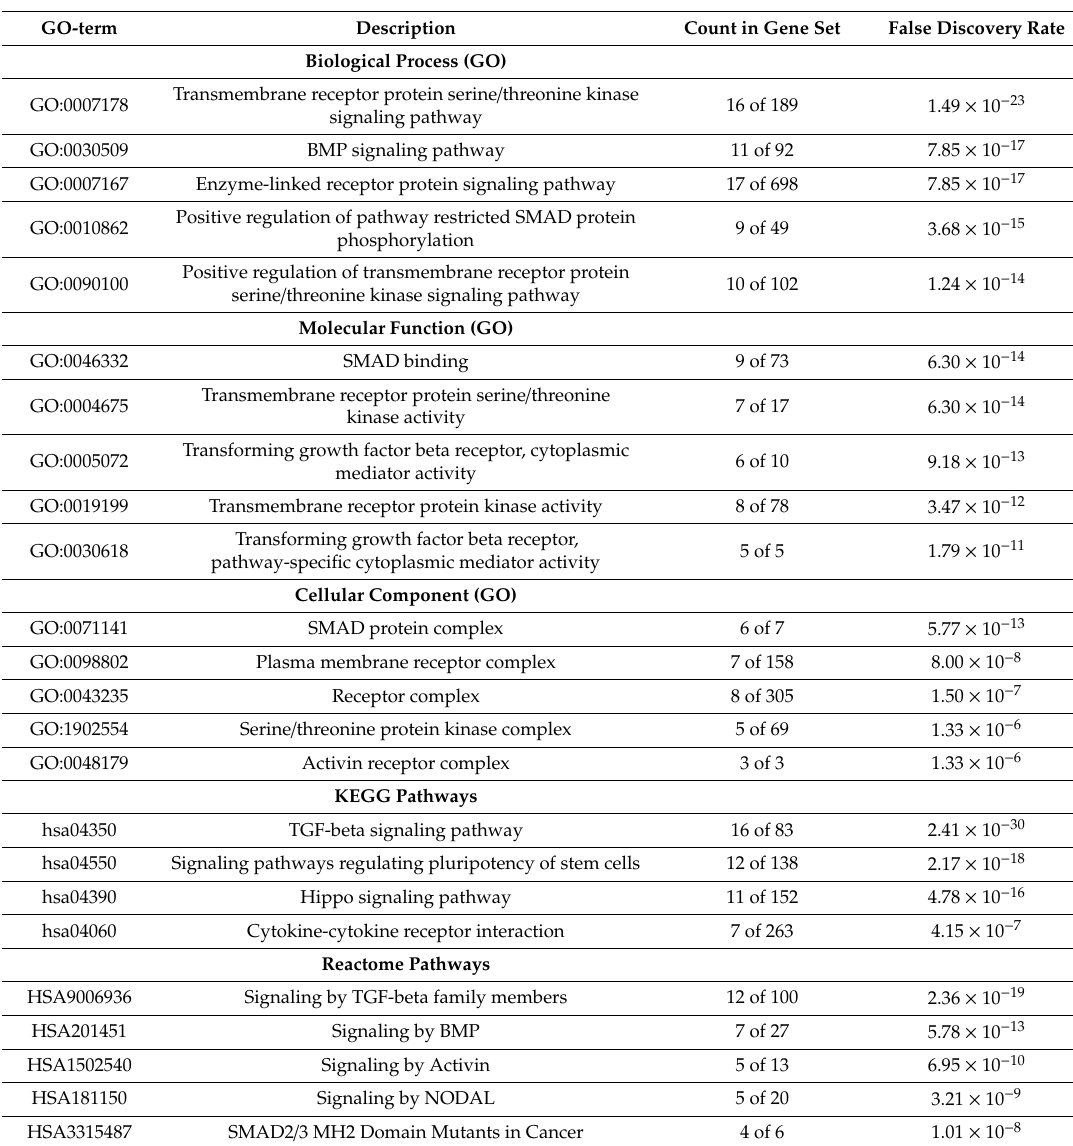
Table 6. Biological Process (GO), Molecular Function (GO), Cellular Component (GO) with KEGG, and Reactome Pathways for the NIPA2